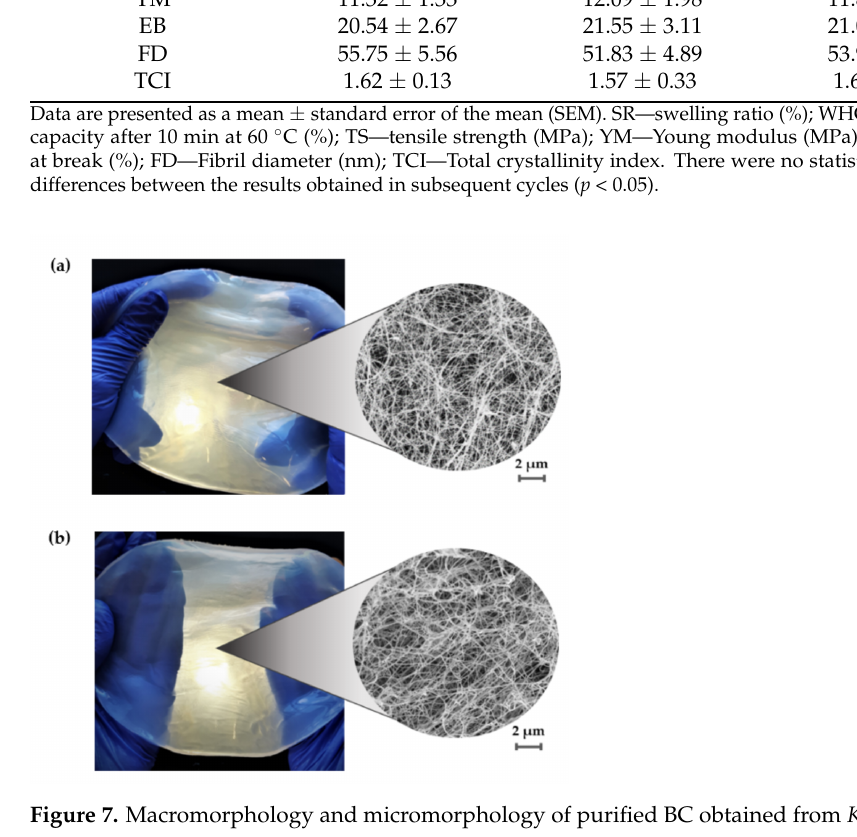
Figure 7. Macromorphology and micromorphology of purified BC obtained from K. xylinus ATCC 53524 culture using inoculum produced in RMF-assisted EL-ALB after ( a ) 96 h and ( b ) 168 h; magnifi- cation 10,000 × (SEM, Auriga 60, Zeiss, Oberkochen,